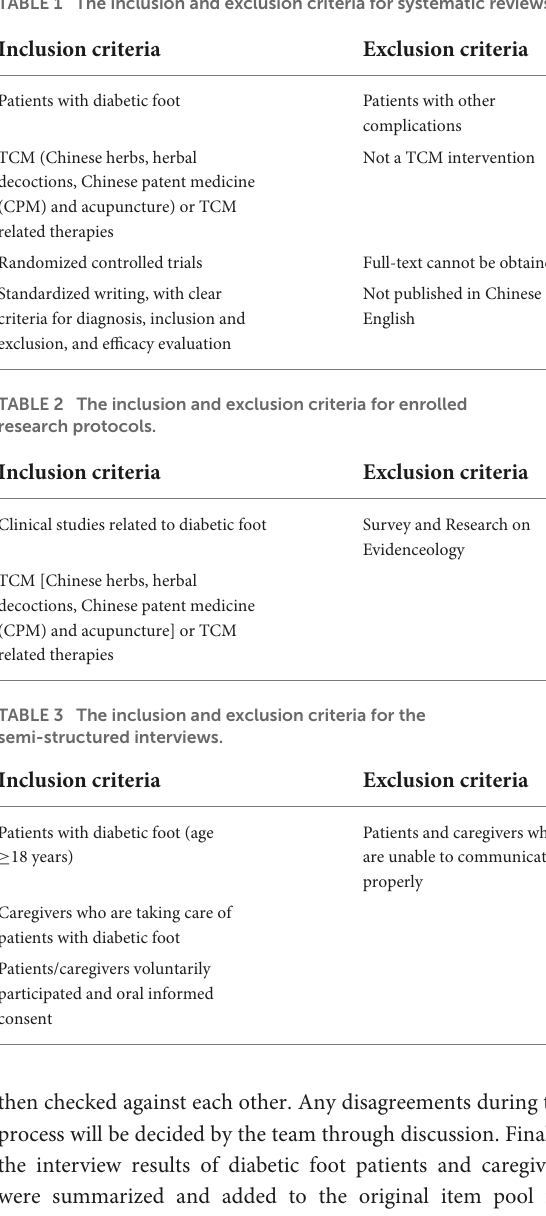
TABLE 1 The inclusion and exclusion criteria for systematic reviews. TABLE 4 The outline of the semi-structured